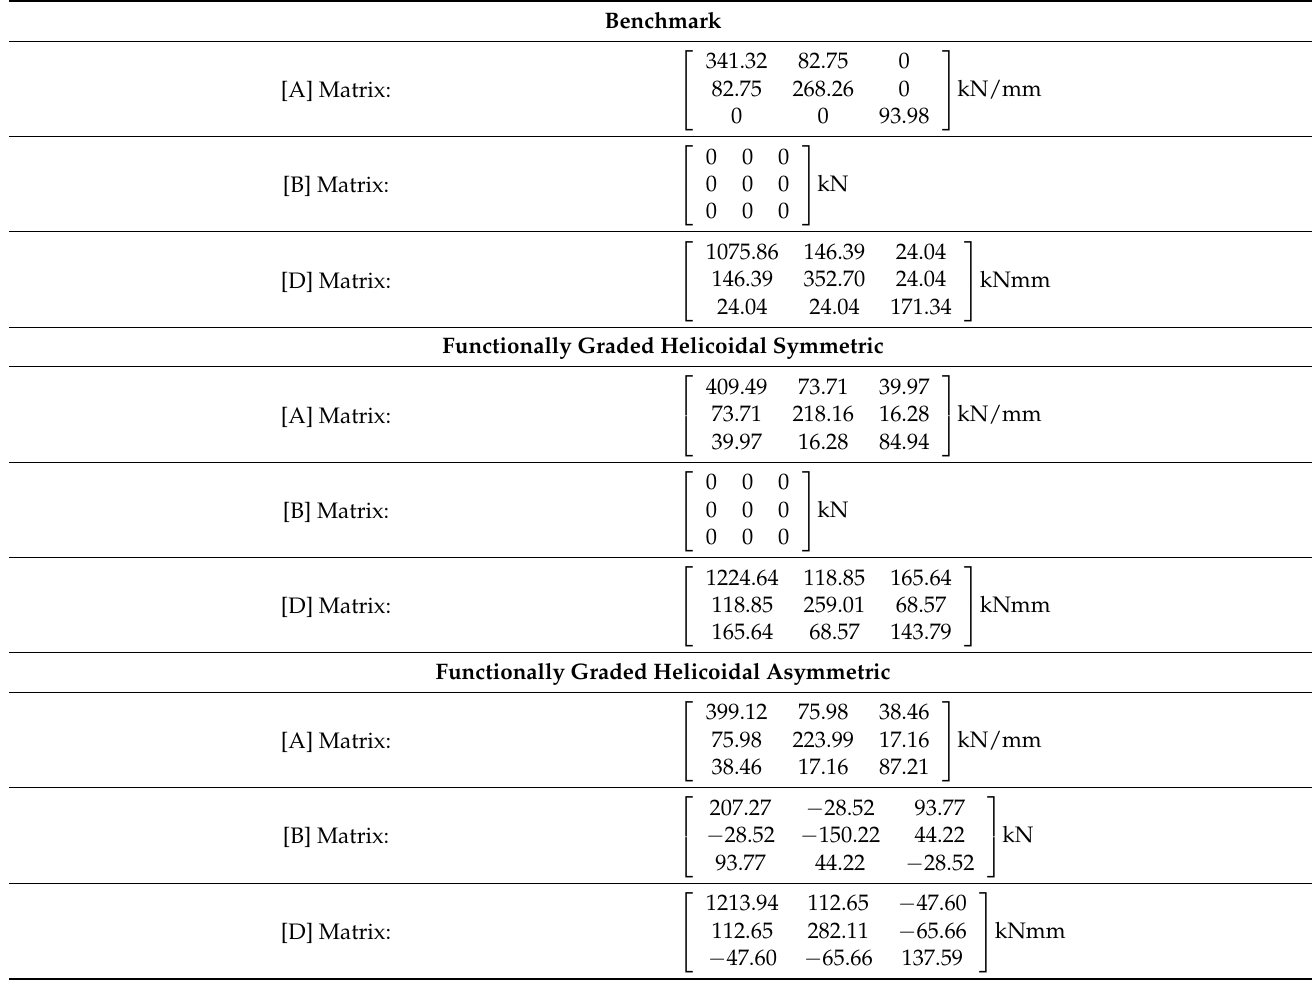
Table A1 data were calculated for each configuration using Equations (A8)–(10) and considering the lamination sequences reported in Table 1. Table A1. Composite laminate matrices.